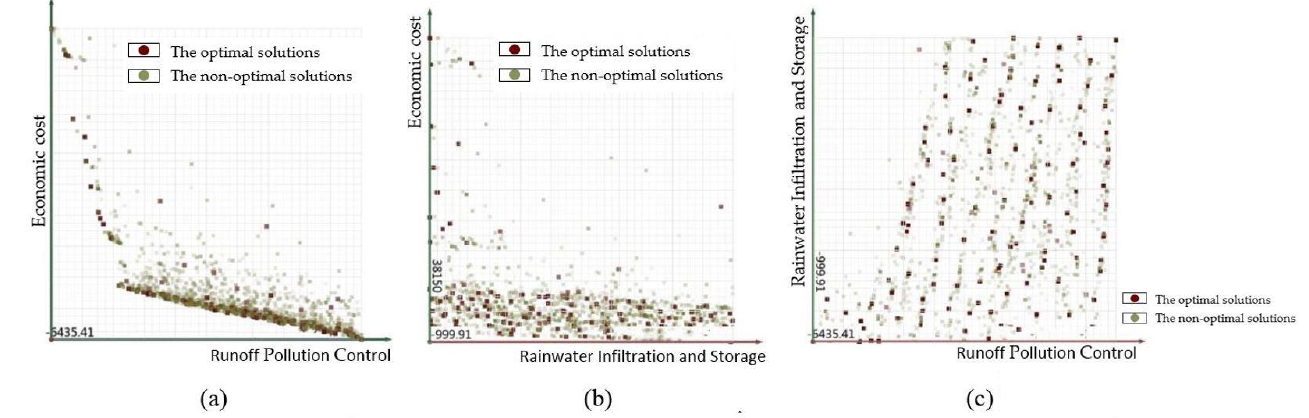
Figure 8. (a) Pareto front distribution of runoff pollution control (x-axis) and economic cost (y-axis);. (b) Pa- Figure 8. ( a ) Pareto front distribution of runoff pollution control ( x -axis) and economic cost ( y -axis); reto front distribution of rainwater infiltration and storage (x-axis) and economic cost (y-axis);(c) Pareto front ( b ) Pareto front distribution of rainwater infiltration and storage ( x -axis) and economic cost ( y -axis); distribution of runoff pollution control (x-axis) and rainwater infiltration and storage (y-axis) ( c ) Pareto front distribution of runoff pollution control ( x -axis) and rainwater infiltration and storage ( y -axis).